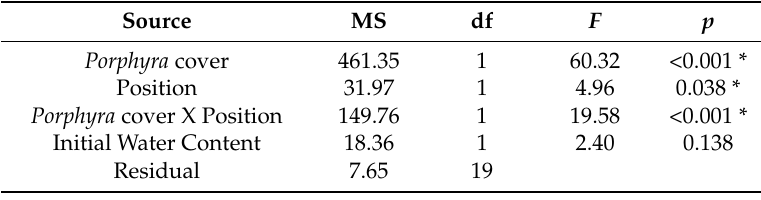
Figure 3. Mean (SE) temperature of plastic cards placed above and underneath the mussel layer in Porphyra -covered and exposed control areas. Three measurements were made during a daytime, air exposure period (Low tide at 1:59 p.m.). Different letters above bars indicate significant differences within each measurement time. Table 3. Two-way ANCOVA model relating water loss from pre-wetted absorbent cloth pieces (i.e., a measure of relative desiccation) with Porphyra cover (Yes/No), Position of the cloth pieces (Above/Underneath the mussel layer), and their Initial Water Content (continuous covariate, range 30.00–35.50 mL). Asterisks indicate significant effects.